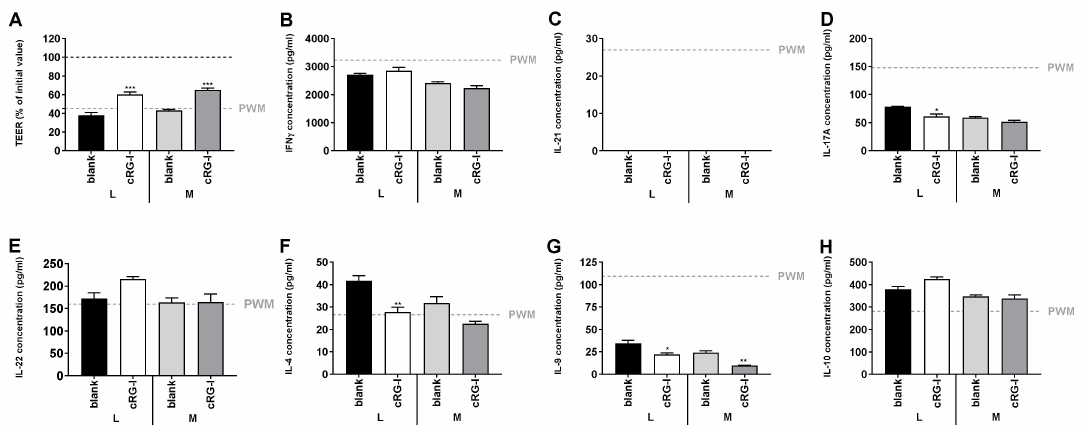
Figure 6. E ff ect of fermented cRG-I on transepithelial electrical resistance (TEER) and cytokine production in a Caco-2 / PBMC co-culture system. Caco-2 cells, cultured 14 days on transwell inserts, were placed on top of pokeweed mitogen (PWM)-activated PBMCs and incubated for 48 h at the apical side with blank or treatment samples collected during the colonic batch incubations containing only a luminal (L) or also a mucosal (M) environment. Average ( ± SEM) TEER of the Caco-2 monolayers ( A ) and concentration of secreted interferon (IFN) γ ( B ), interleukin (IL)-17A ( C ), IL-21 ( D ), IL-22 ( E ), IL-4 ( F ), IL-9 ( G ) and IL-10 ( H ) in the basolateral medium are shown (n = 3). Statistically significant di ff erences to PWM are represented by (*). (*) = p < 0.05, (**) = p < 0.01, (***) = p <